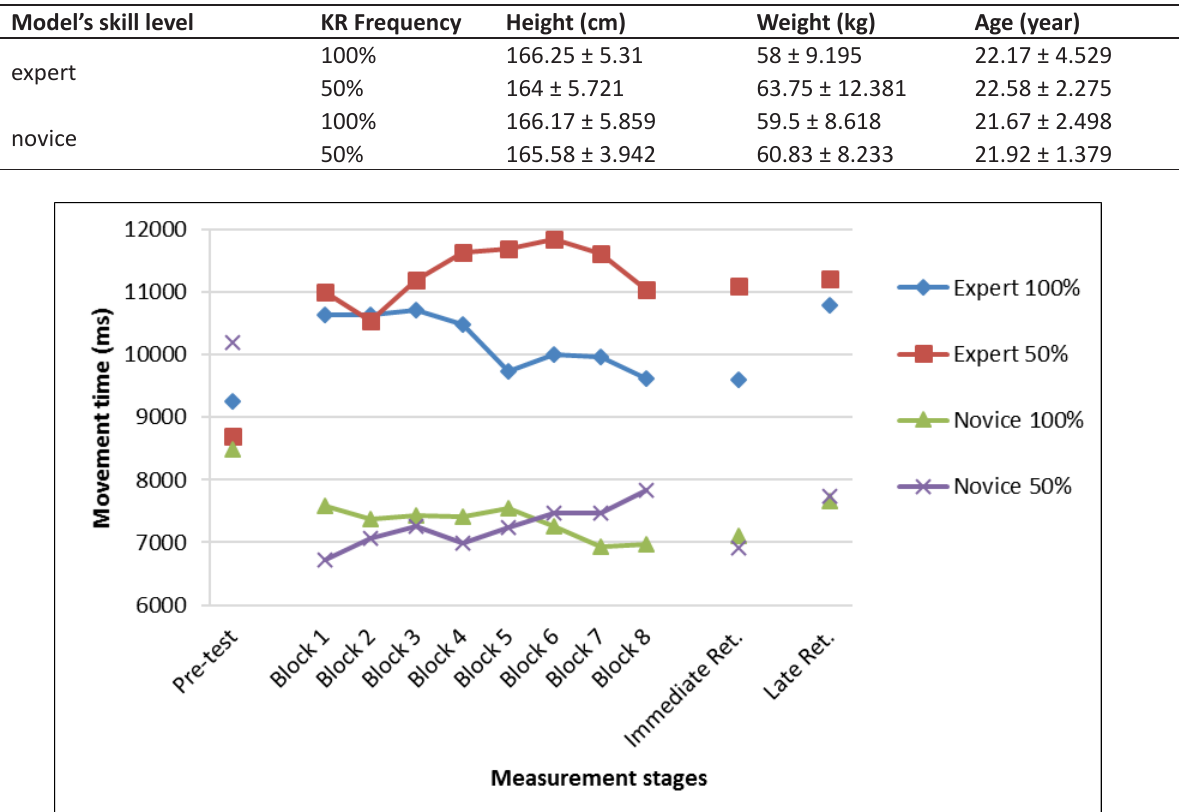
Figure 1. Mean of movement time of complex task at different measurement